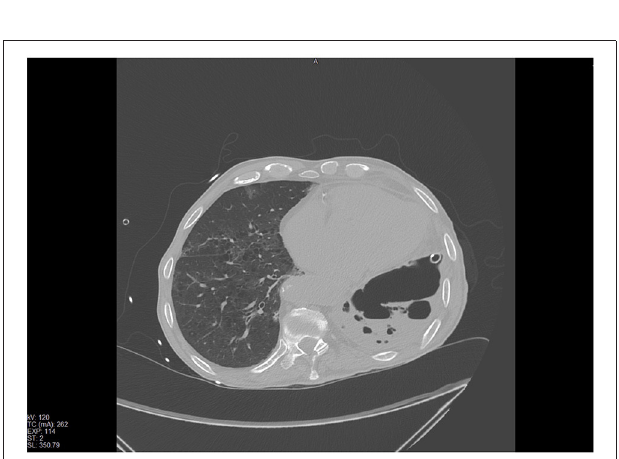
FIGURE 4 | Chest CT scan revealing a non-homogeneous increase in density, diffuse GGO and consolidations at the right lung.